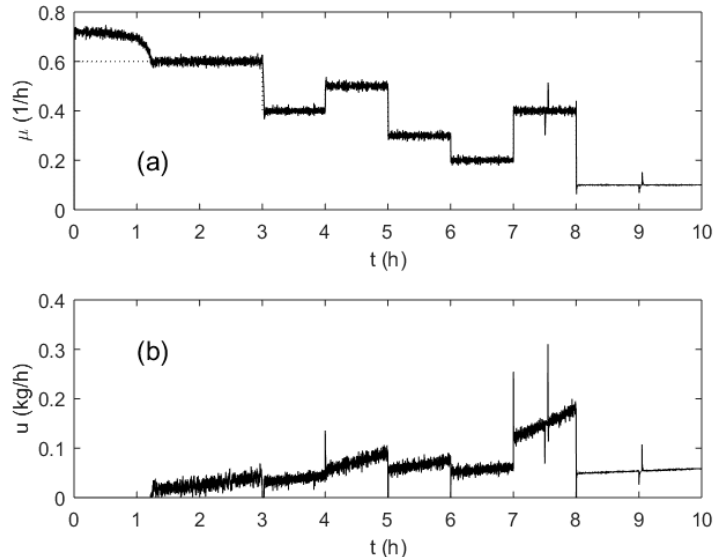
Figure 8. Specific growth rate ( a ) and substrate feeding rate ( b ) trajectories during a test run. Tuning of the adaptive PI controller was performed to minimize the average tracking error